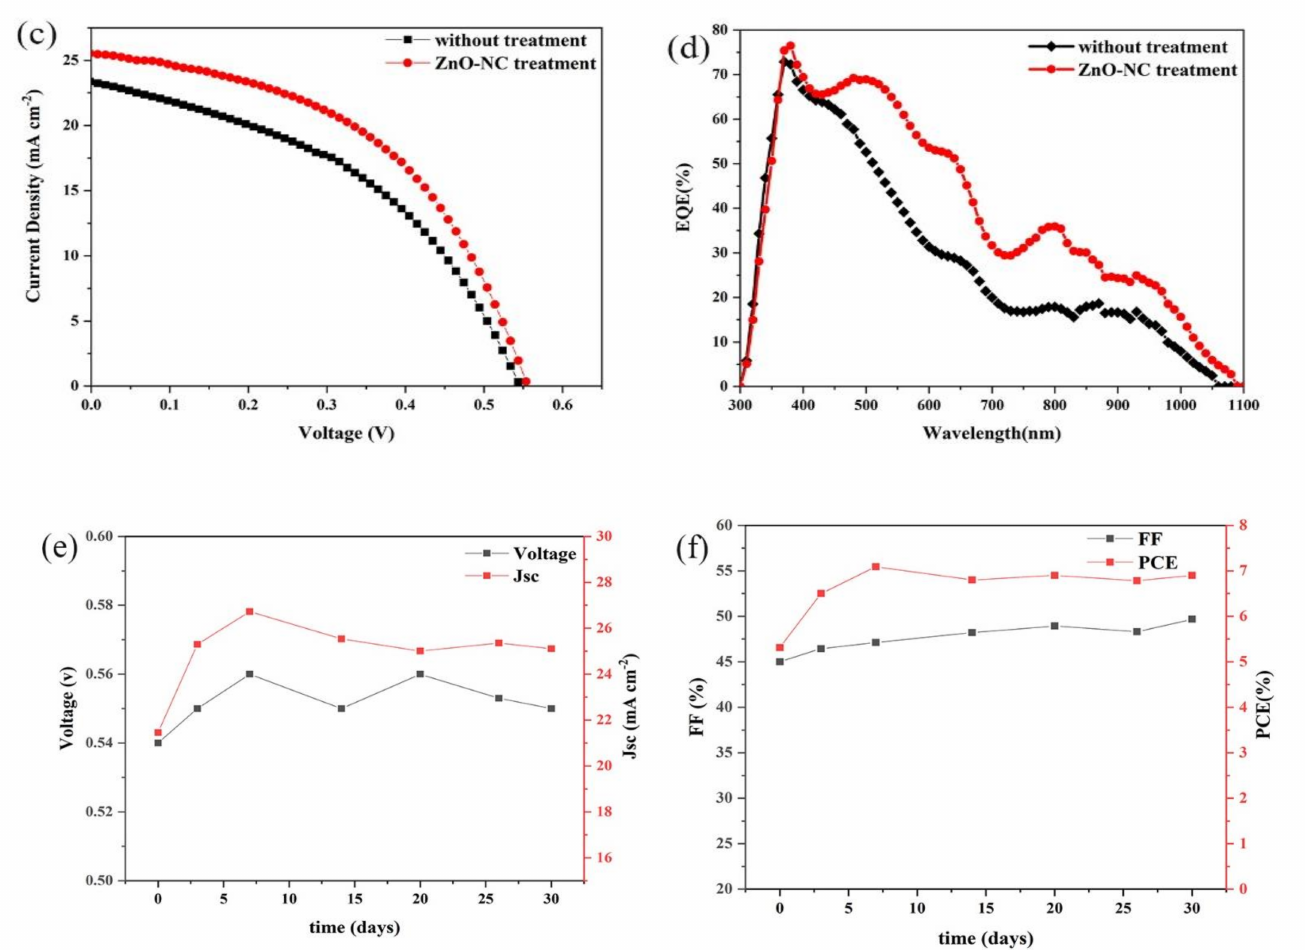
Figure 5. ( a ) The device structure of CQD solar cells, ( b ) cross-section SEM image of ITO/Mg-doped ZnO(MZO)/ZnO NC/PbS CQD thin film. ( c ) The J-V curves for optimized PbS CQD solar cells with and without ZnO NCs, and corresponding ( d ) EQE spectra. Stability test of CQD solar cells ( e ) V oc and Jsc and ( f ) FF and PCE; devices are stored under ambient conditions and all devices are encapsulated. Table 2. Summarized photovoltaic parameters of PbS CQD solar cells prepared with different ZnO NC thicknesses